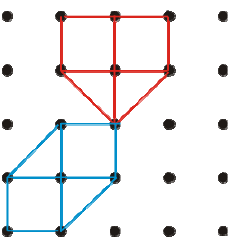
Figure 1. Edge Protection Smoothing Operator An edge protection smoothing operator is shown in Figure 1, in which the black solid circles represent pixels and the red and blue polygons represent directional pointers. In a window of 5 by 5 pixels, the pointers cover eight directions. The steps for executing this operator include: (1) computing the variance of gray values of the covered pixels in each pointer; (2) treating the direction with maximum variance as an edge, while regarding the minimum variance as plainness; (3) substituting the average value for the central value in the direction with the minimum variance; (4) shifting the window until the image is ergodic. After the application of this operator, the compression rate of a certain image is expected to be further improved.